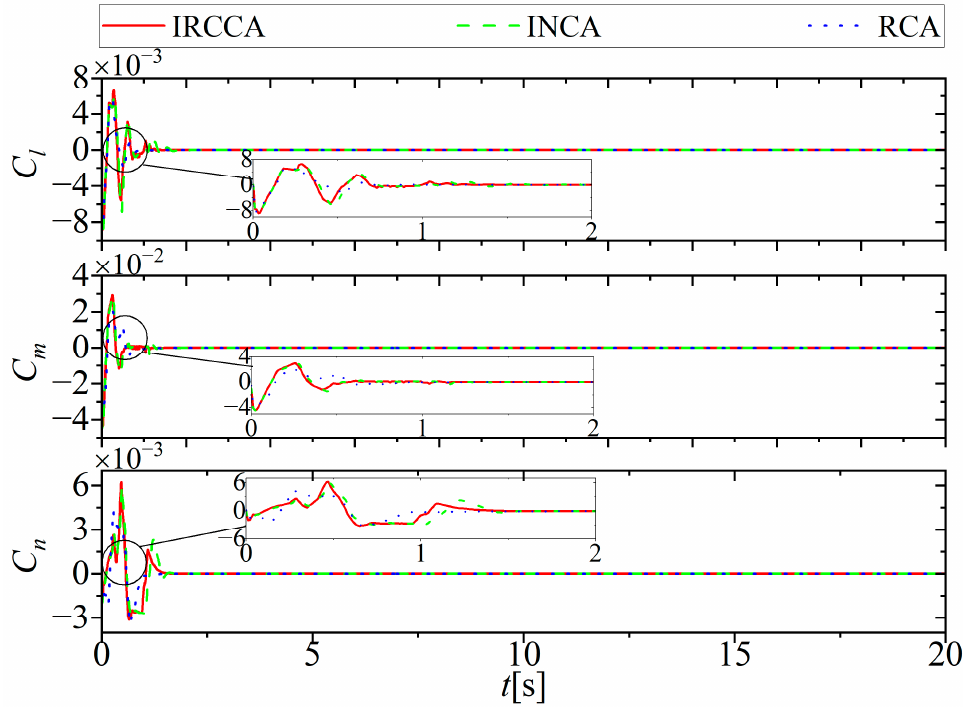
Figure 15. Time response of the moment coefficient with a loss of effectiveness fault.